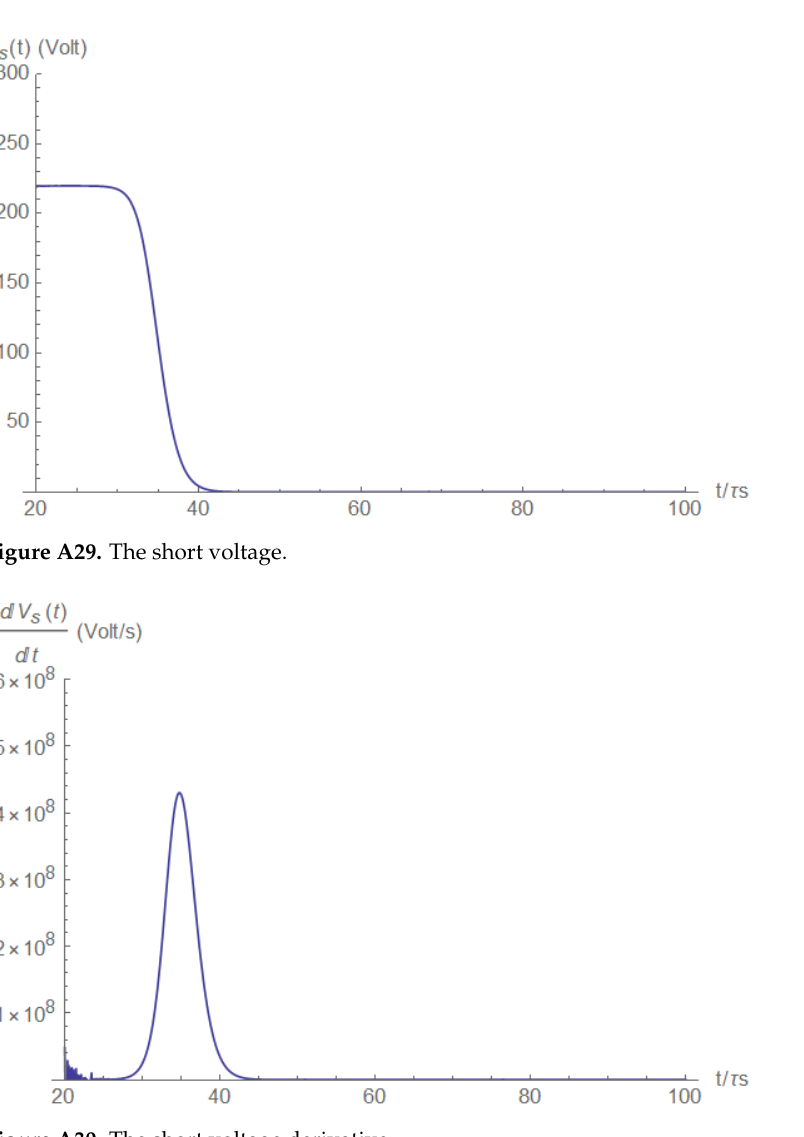
Figure A30. The short voltage